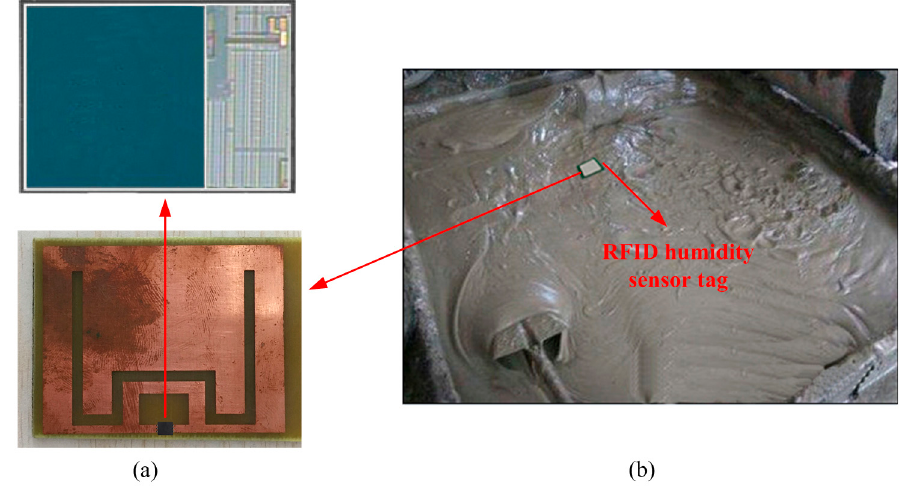
Figure 13. ( a ) Photo of the proposed tag chip; ( b ) Concrete measuring environment.